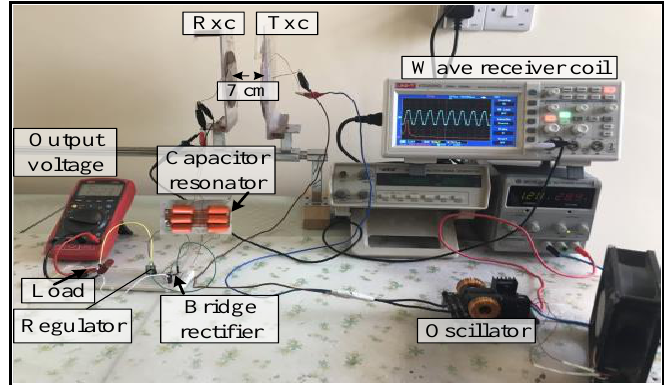
Figure 4. A snapshot of the MRC system at 7 cm for first topology at load.